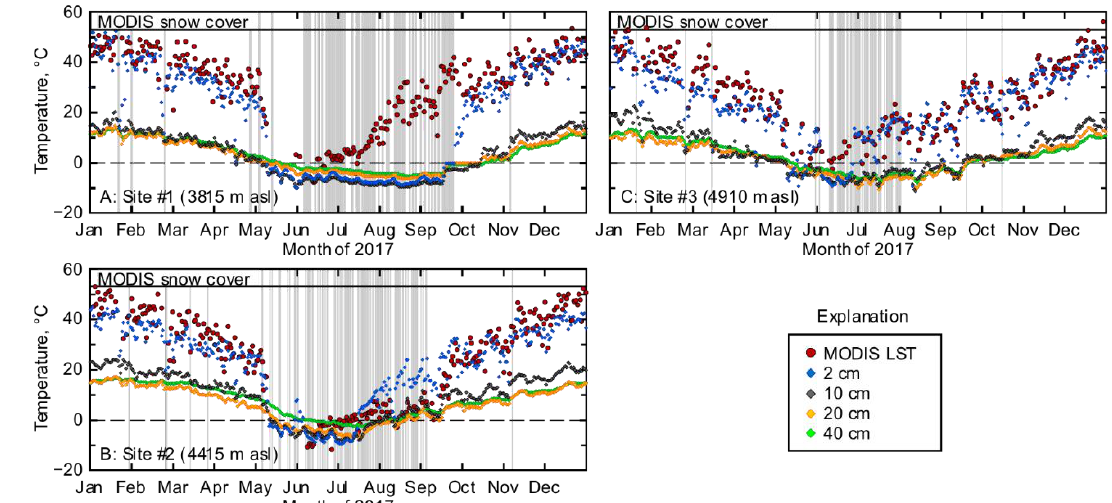
Figure 8. Validation site temperatures at 2 PM. ( A ) Site #1. Between early June and mid-July, LSTs were near freezing and the 2 cm temperatures were about the same as at 10 cm, by late September increasing to 0 ◦ C, later rising to match the LST. ( B ) Site #2. There was a late-June zero curtain in the LST. After the thaw, the LST was lower than the 2 cm temperature. ( C ) Site #3. Subsurface zero curtains, but none in the LST, occurred during both and freeze-up. The MODIS snow cover data is MYD10A1 [46].